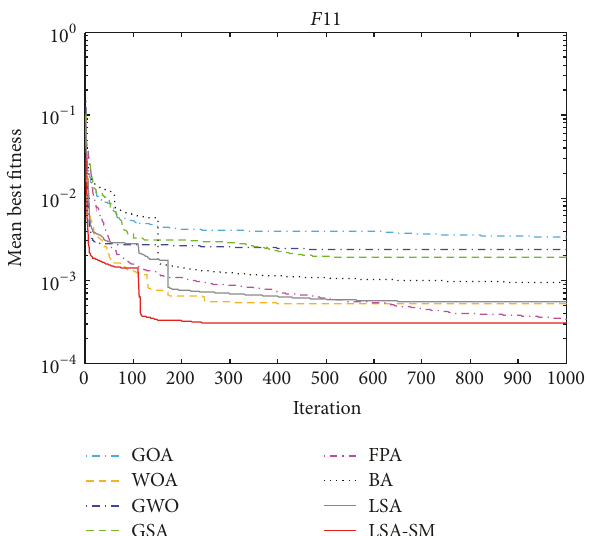
Figure 17: 𝐷 = 2 , convergence curves for 𝑓 13